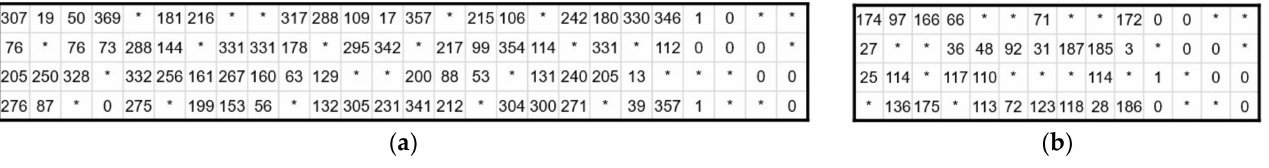
Figure 1. The base matrices of ( a ) rate-11/13 BG 1 and ( b ) rate-5/7 BG 2 in the 5G NR standard. The element * is a zero matrix and 0 is an identity matrix. The element of non-zero integer denotes a cyclic-shifted matrix with a shifted